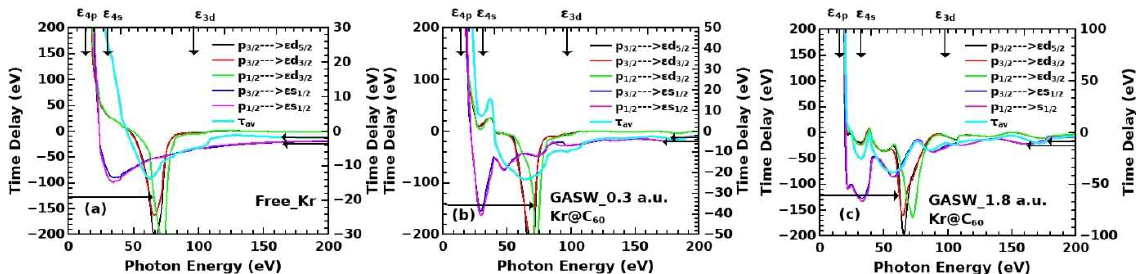
Figure 9. Time delay of photoionization from the 4p subshells of ( a ) free ( left panel ) and confined Kr with the depths of ( b ) 0.3 a.u. ( middle panel ) and ( c ) 1.8 a.u. ( right panel ). Left and right axes are the time scale of the p → ε d and p → ε s channels, respectively, which are indicated by the horizontal arrows. The average time delay ( τ av ) is also linked to the right axis. Vertical arrows indicate the threshold values of the corresponding subshells used in the RRPA.